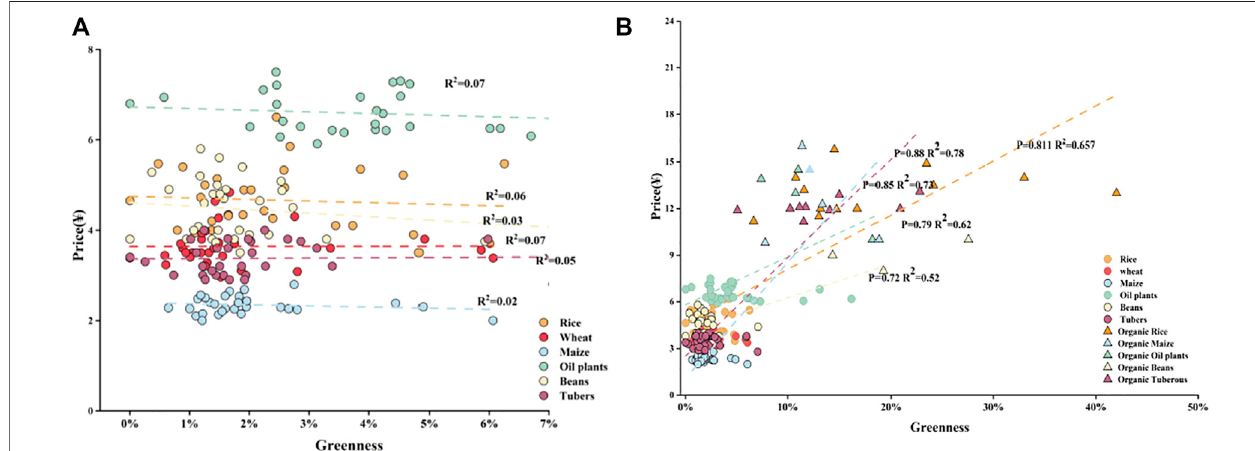
FIGURE 6 | Greenness (A) and price (B) of typical agricultural products.